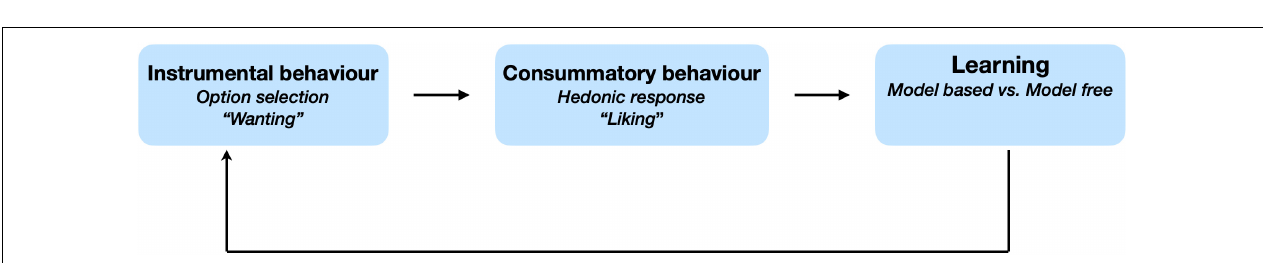
FIGURE 1 | Negative symptoms and conceptual groupings. Negative symptoms are often conceptually grouped into a motivation and pleasure (MAP) and blunted expression (EXP) components. The former includes anhedonia, avolition, and asociality, whereas the latter includes alogia and emotional responsiveness. Collectively, the motivation-pleasure symptoms are also sometimes referred to using the umbrella term “apathy.”